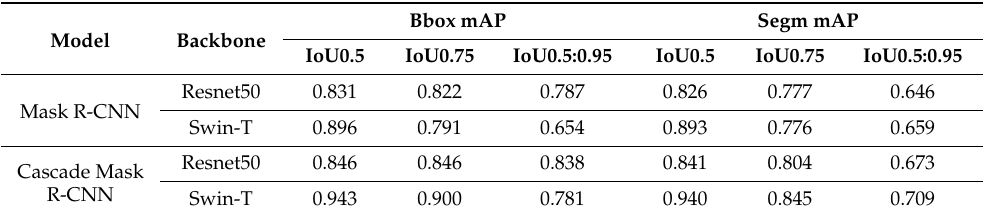
Table 2. mAP values of four algorithms under different IOU thresholds.